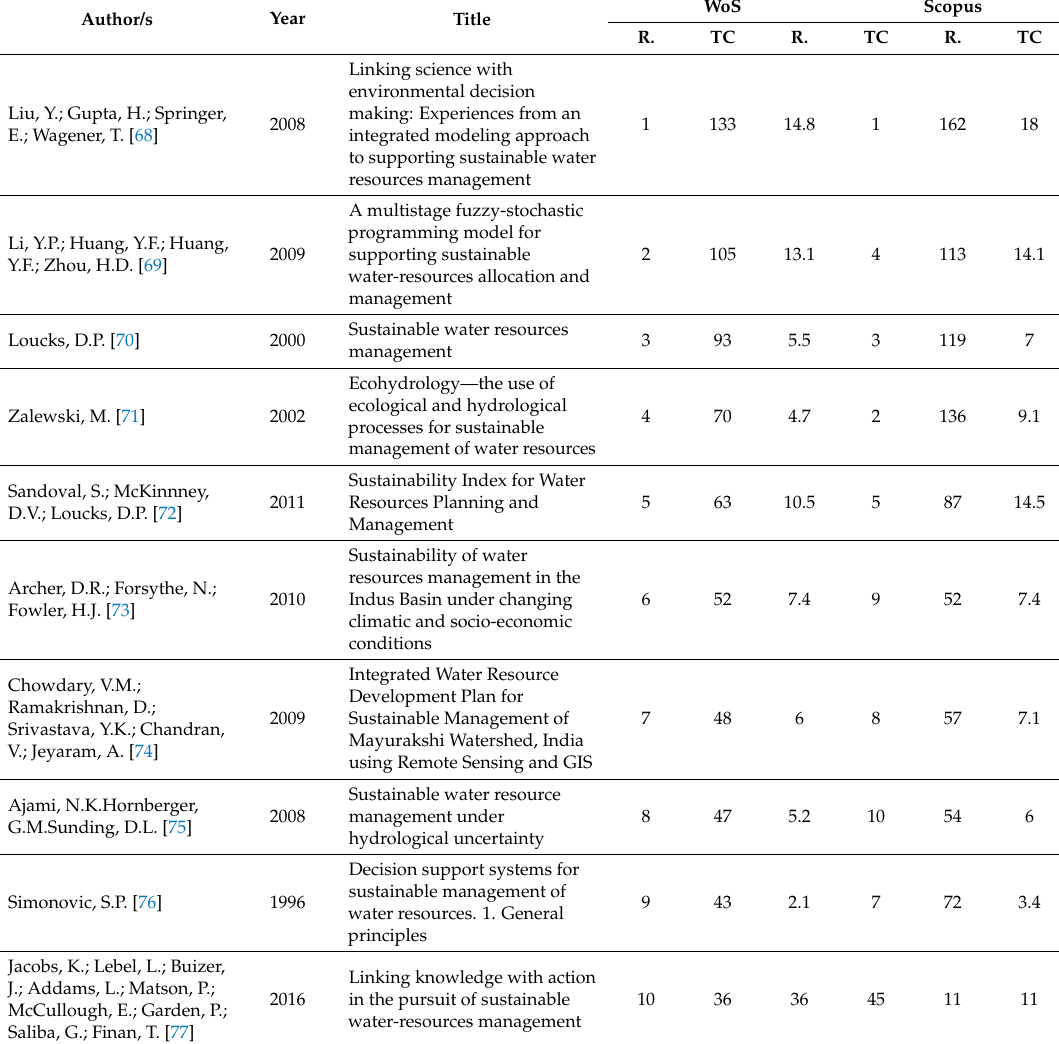
Table 3. Ranking of articles on Sustainable Water Resources Management most cited in WoS/Scopus.